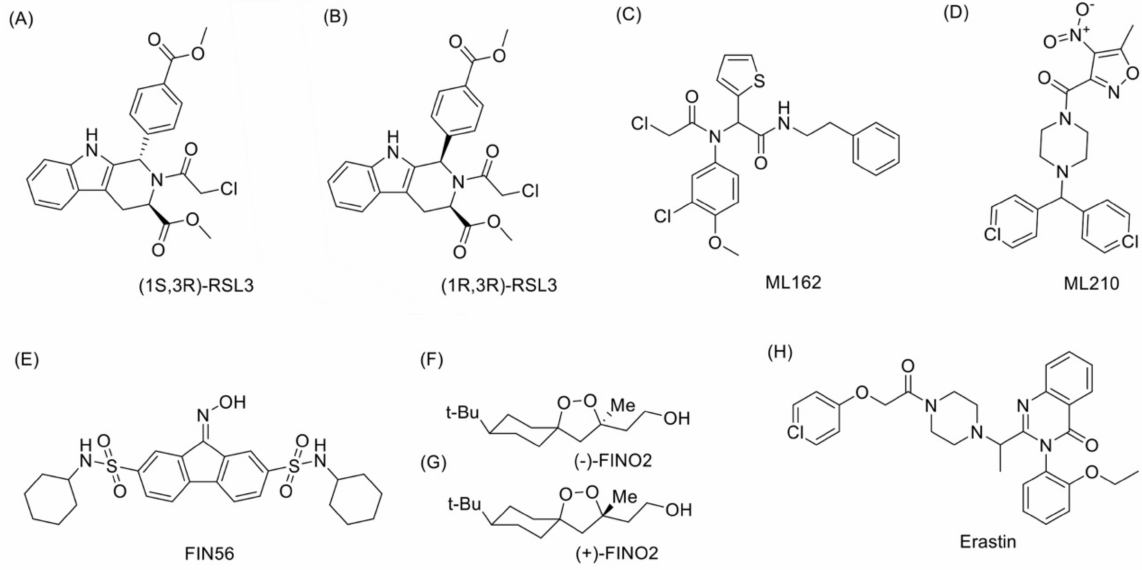
Figure 2. Structures of GPX4-related molecules mentioned in the article. ( A ) (1S-3R)-RSL3, or RSL3, the first described Class II inhibitor that directly targets GPX4 to trigger ferroptosis. ( B ) (1R-3R)-RSL3, a diastereomer of (1S-3R)-RSL3, which loses its HRAS selectivity. ( C , D ) ML162 and ML 210, the